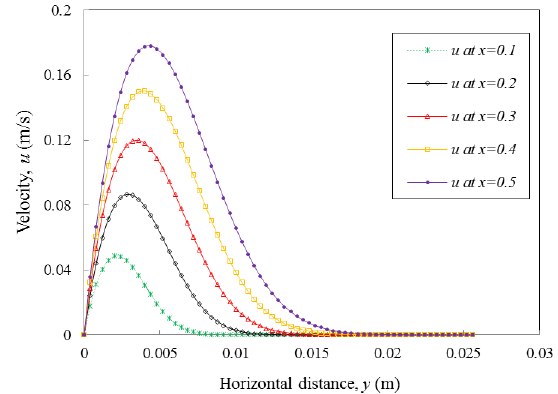
Figure 4. Velocity profiles for methane in vertical direction at various locations along heated vertical tube